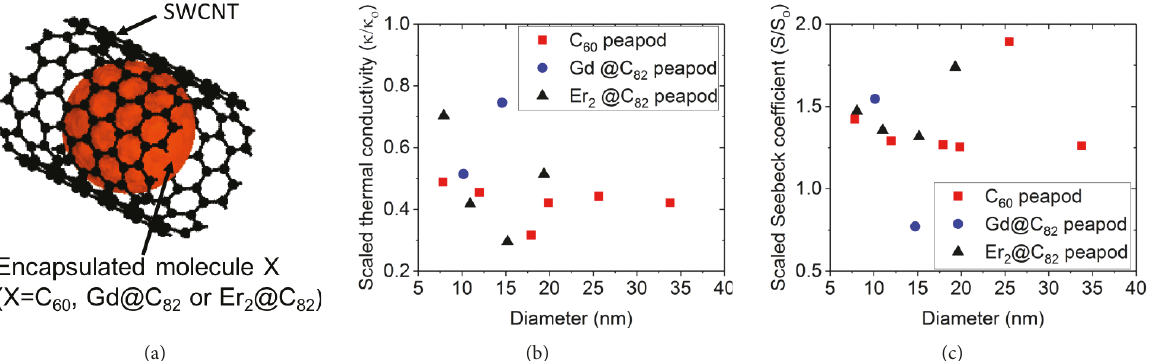
Figure 9: (a) Schematic of SWCNT encapsulated with molecules. ((b) and (c)) Scaled thermal conductivity and Seebeck coefficient as a function of the diameter of CNT [150].